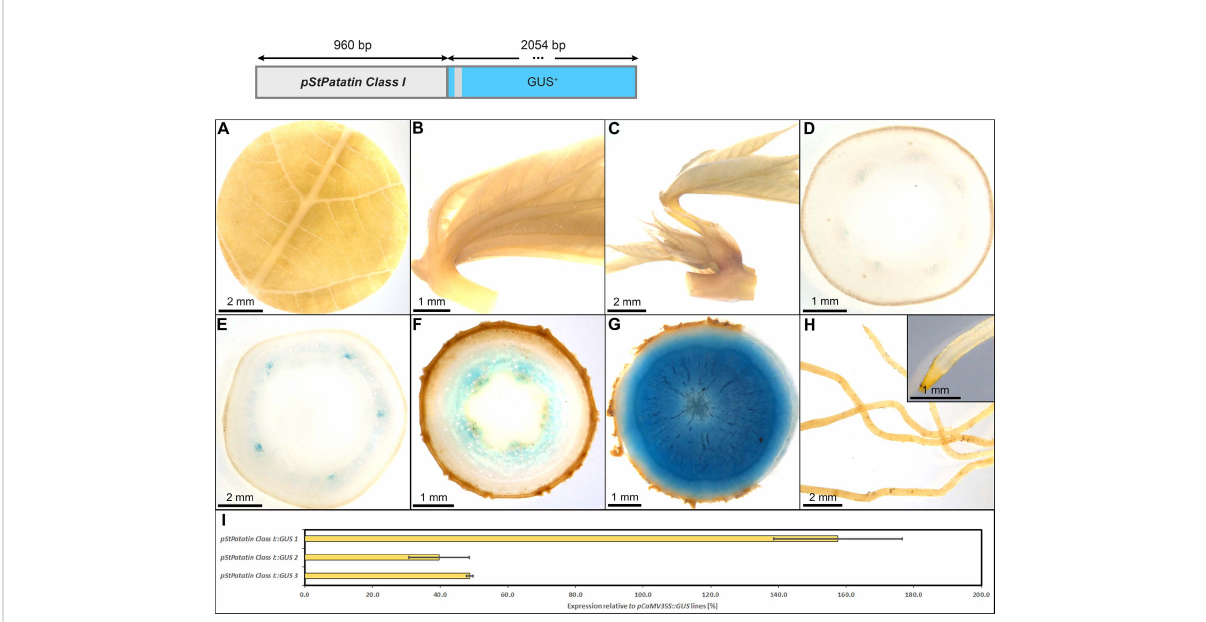
FIGURE 9 Representative GUS staining pattern of four pStPatatin Class I promoter-reporter lines. (A) Source leaf, (B) Sink leaf, (C) Emerging leaves, (D) Petiole cross-section, (E) Upper stem cross-section, (F) Lower stem cross-section, (G) Storage root cross-section, (H) Fibrous roots, (I) GUS expression levels of three pStPatatin : GUS lines relative to three pCaMV35S::GUS lines in %. Bars represent mean values with standard deviation